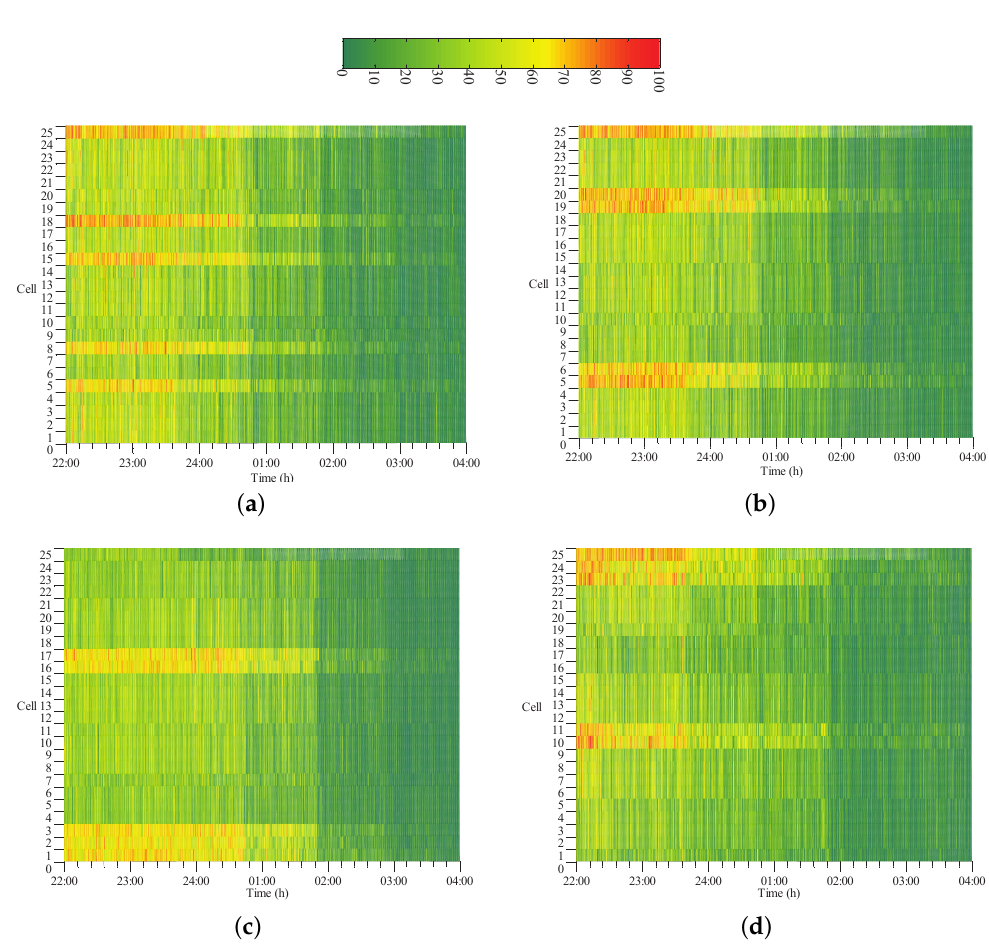
Figure 3. Simulated densities. ( a ) Subsystem 1; ( b ) Subsystem 2; ( c ) Subsystem 3; ( d ) Subsystem 4.